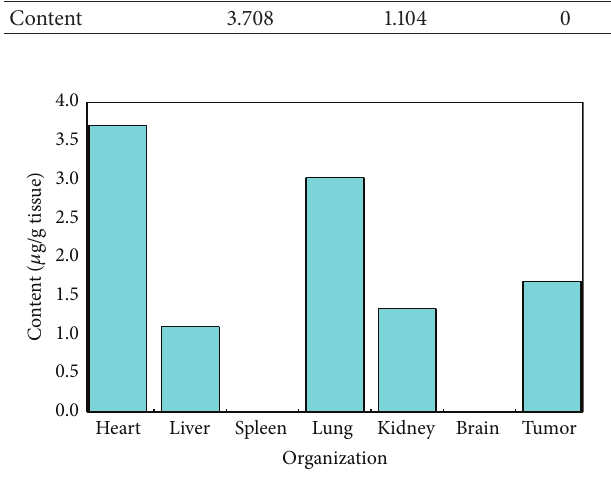
Figure 9: Baicalin content in each group.